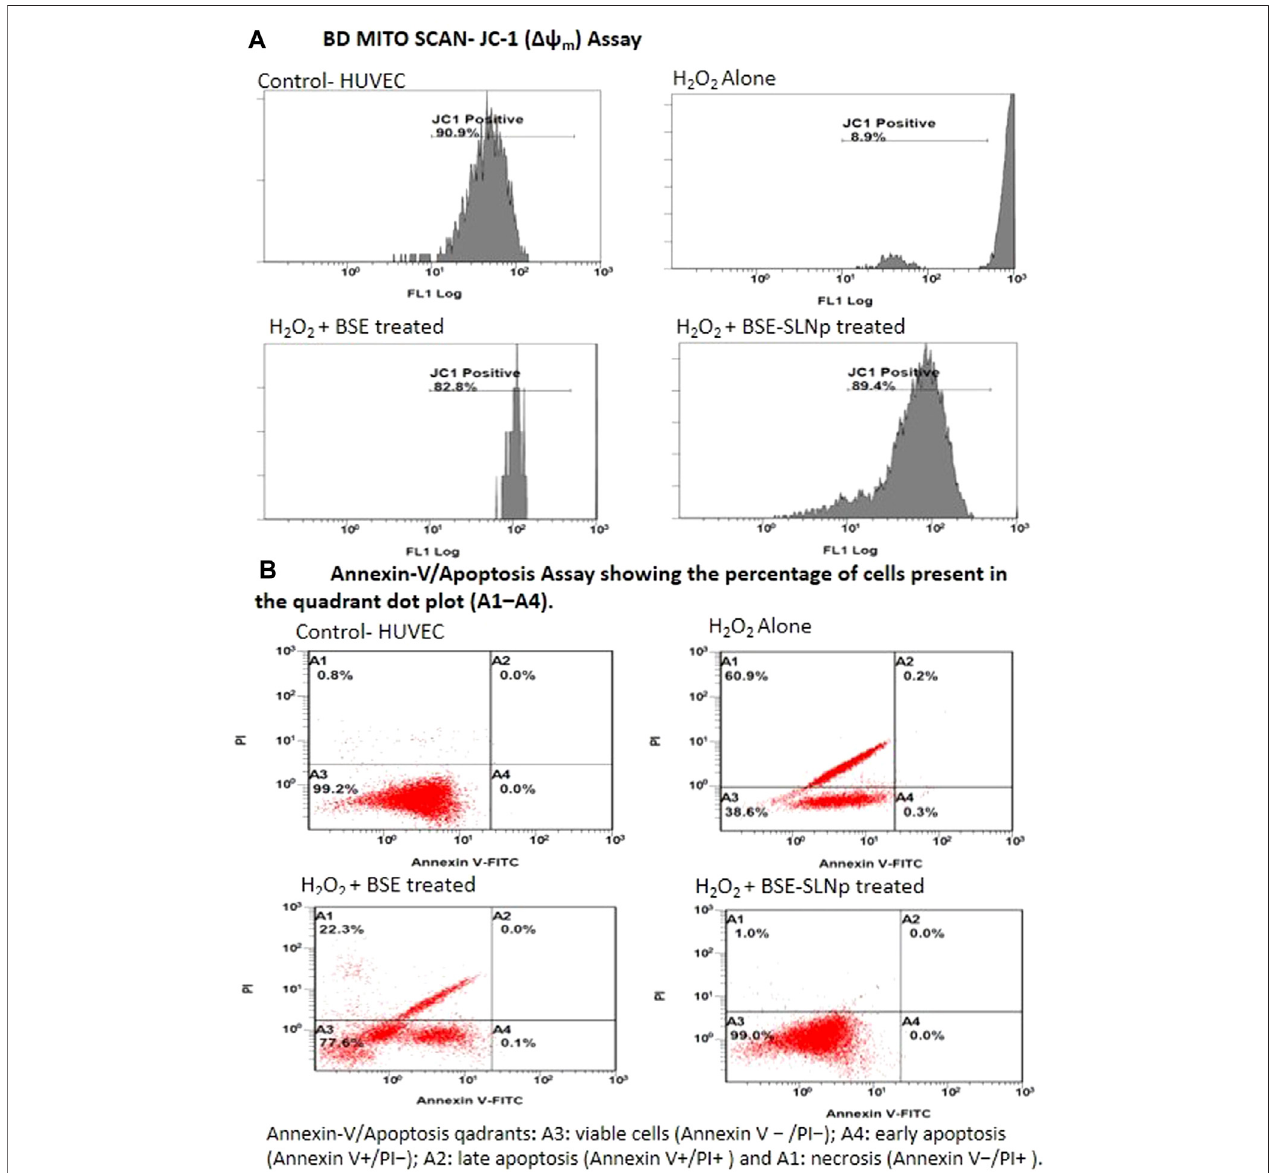
FIGURE 7 | Flow cytometry analysis of JC-1 ( Δψ m , BD Mito Scan) and annexin-V/propidium iodide double staining in H 2 O 2 induced oxidative stressed HUVECs treated with BSE and BSE-SLNp. Untreated cells were considered a negative control, whereas H 2 O 2 (40 mM) was added for positive control.